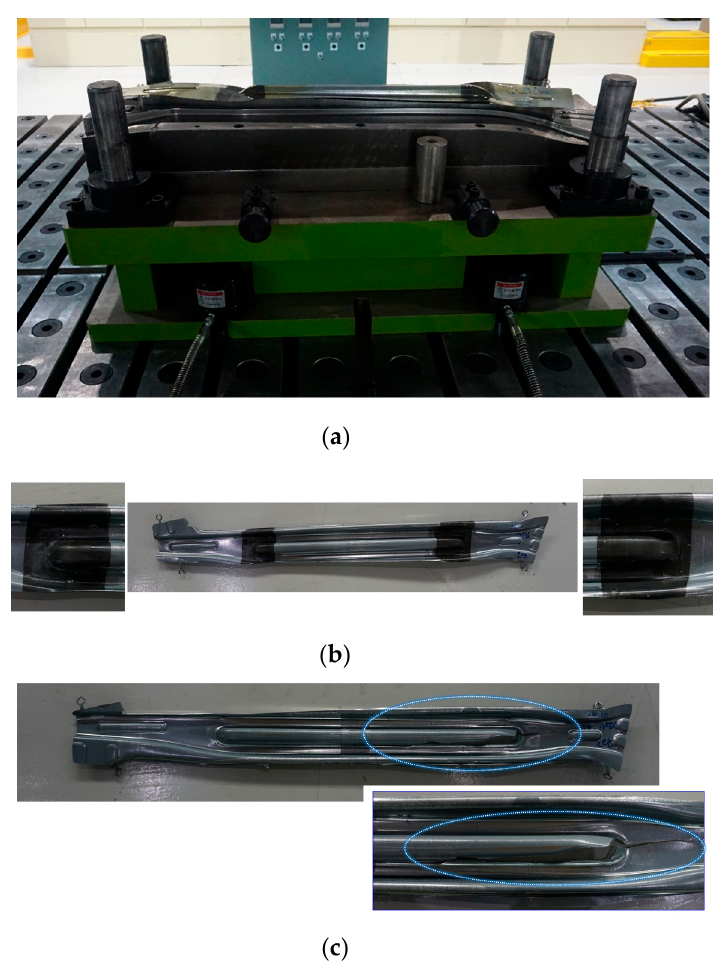
Figure 13. Door impact beam application: ( a ) Press setting; ( b ) Manufactured door impact beam with